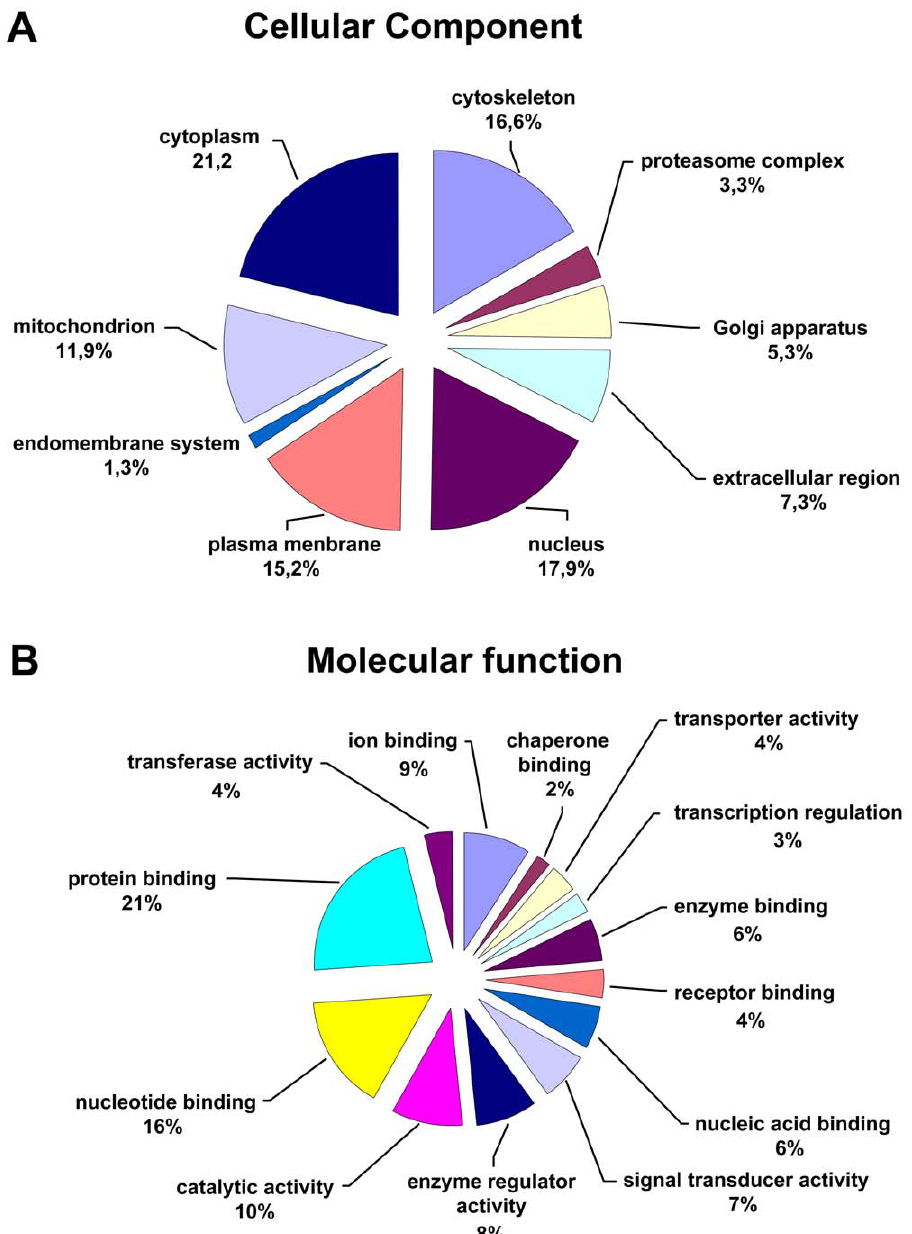
Figure 4. Distribution of identified proteins. Identified proteins were assigned on the basis of information provided by GO lists downloaded from PIR (http://pir.georgetown.edu/).to (a) cellular component or (b) molecular function.